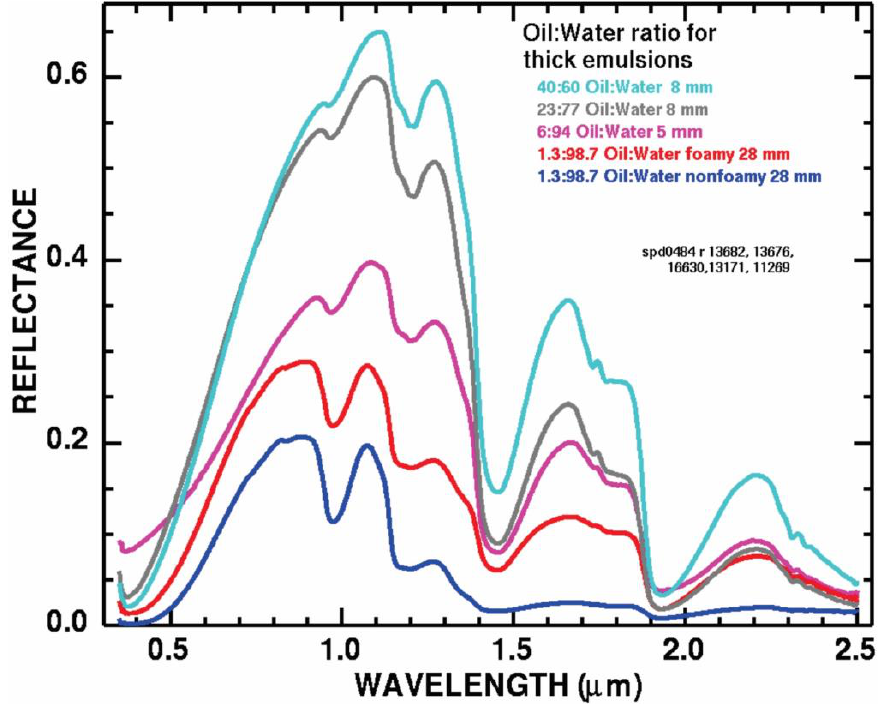
Figure 8. The absorption scheme used to calculate oil thickness from near-IR.